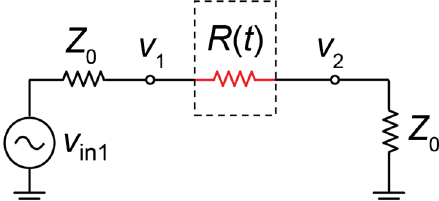
FIG. 11. Schematic of a time-varying resistance used to model a switch, connected to a voltage source through the impedance Z 0 . The load impedance is also Z 0